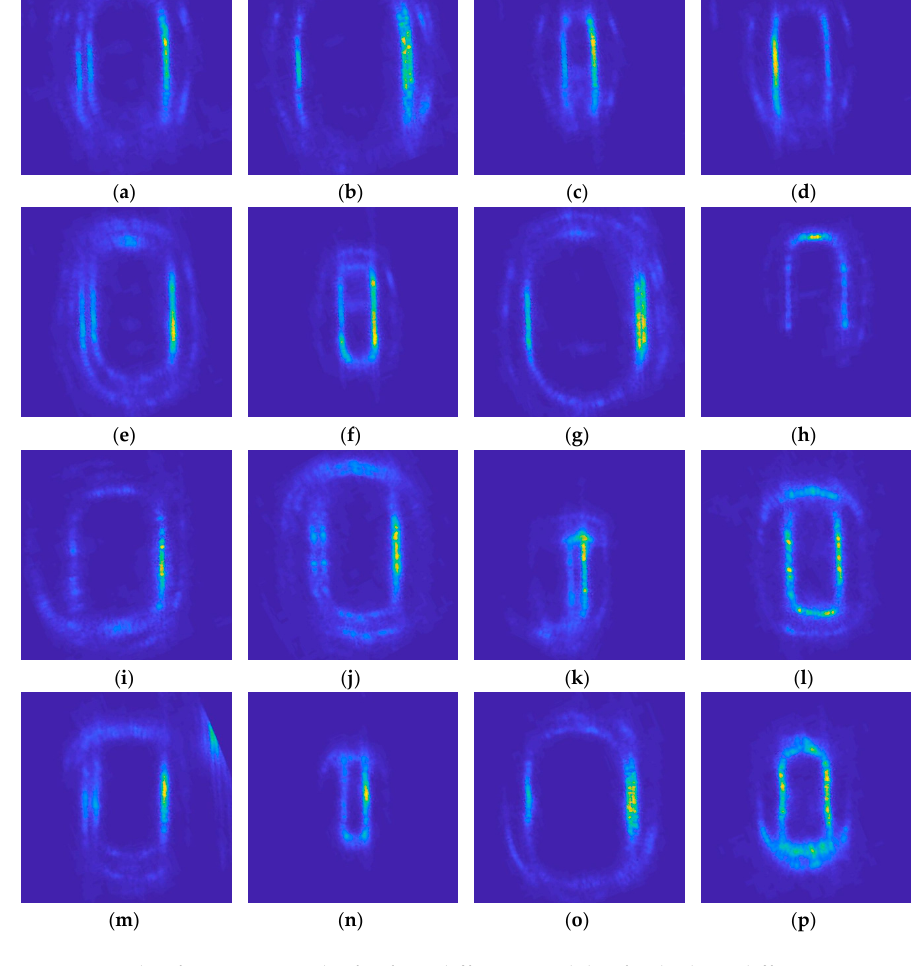
Figure 5. Example of imaging results for four different models of vehicle at different positions and detection heights. ( a – d ) Chevrolet Impala LT; ( e – h ) Mitsubishi Galant ES; ( i – l ) Toyota Highlander; and, ( m – p ) Chevrolet HHR LT.